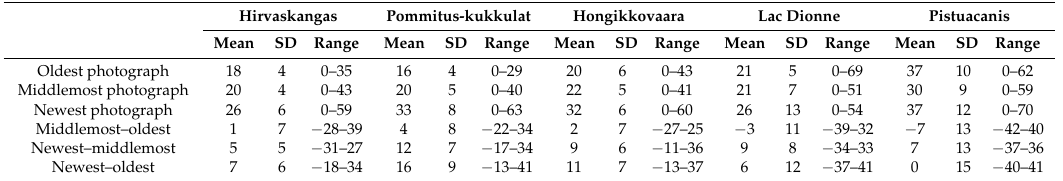
Table 3. The mean canopy cover, canopy cover standard deviations and canopy cover ranges calculated from the oldest, middlemost and the newest aerial photographs, and the mean canopy cover change (as p.p.), its standard deviation and range for the studied time intervals.